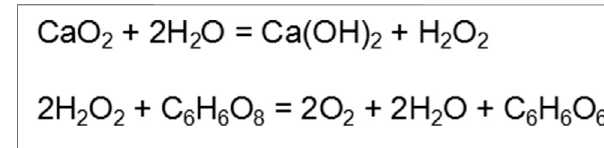
SCHEME 1 | Reaction mechanism between CaO 2 and vitamin